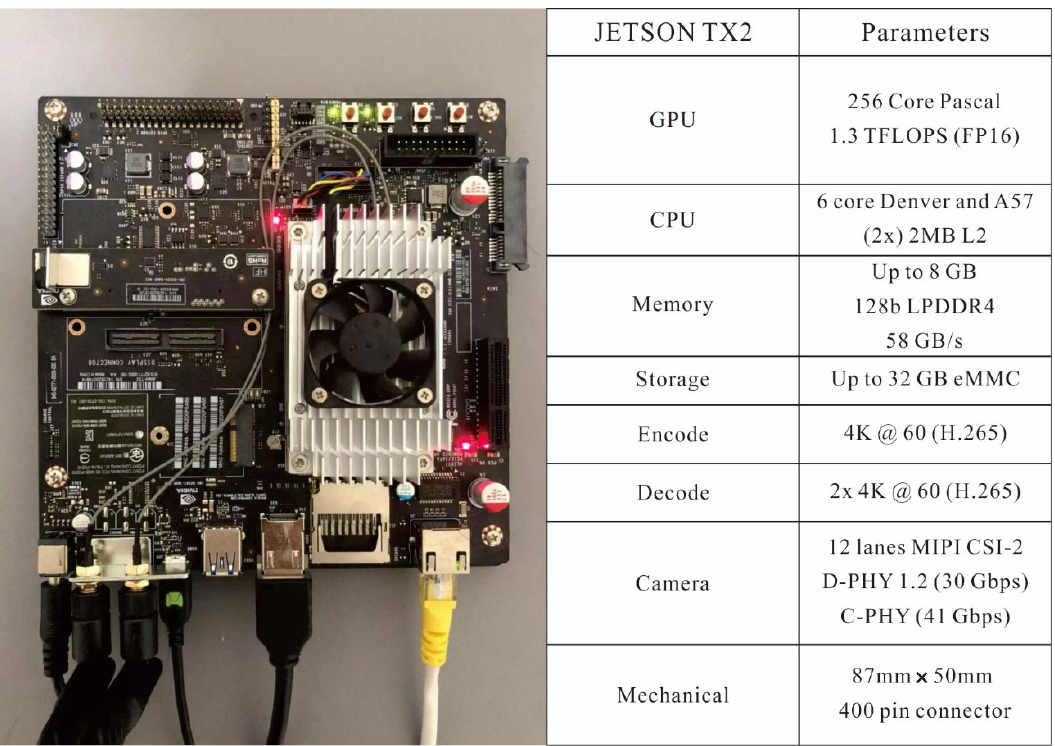
Figure 3. NVIDIA Jetson TX2 parameters.